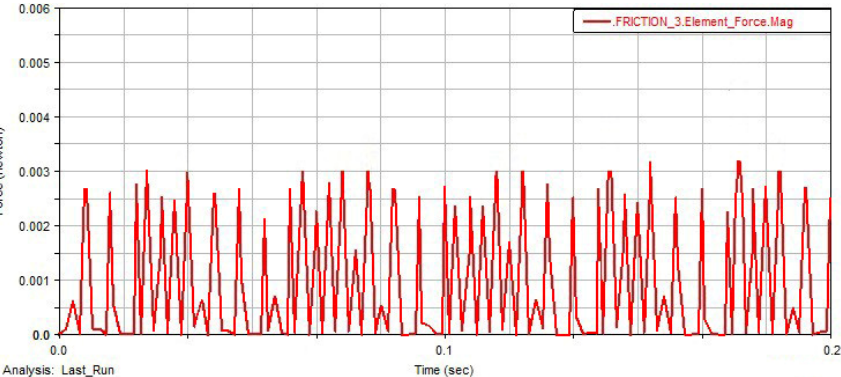
Figure 13. Comparison of friction between slider and rotor slider slot before stator optimization.